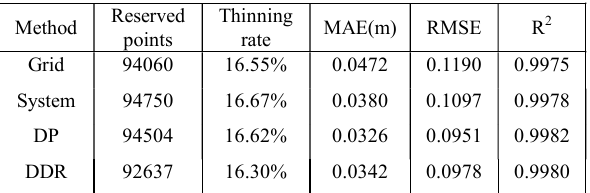
Table 3. Experimental results of the third group